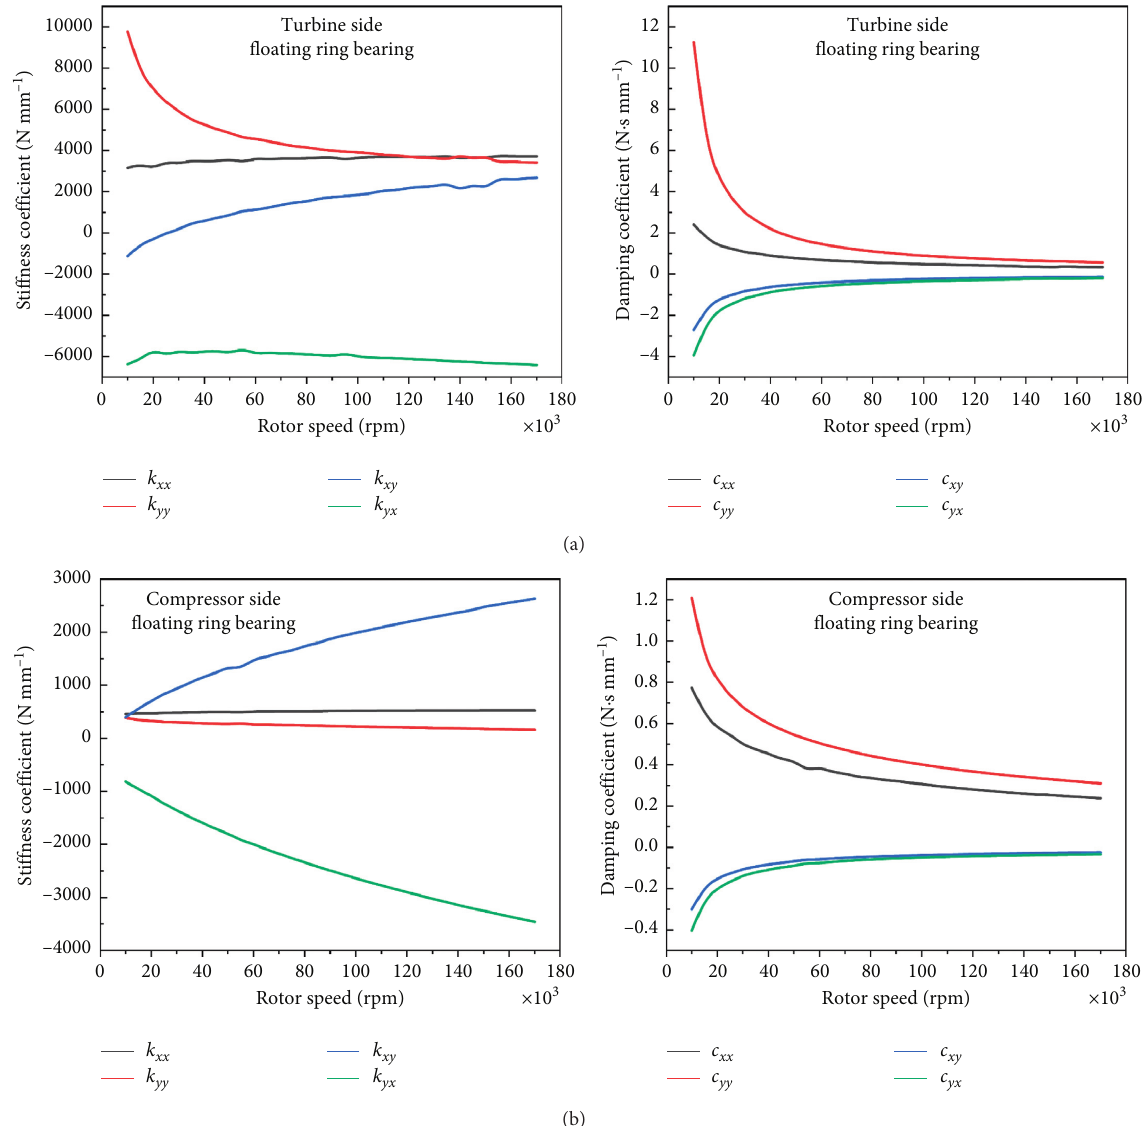
Figure 6: Total impedance of floating ring bearing (equivalent stiffness and damping coefficients). (a) Turbine side. (b) Compressor